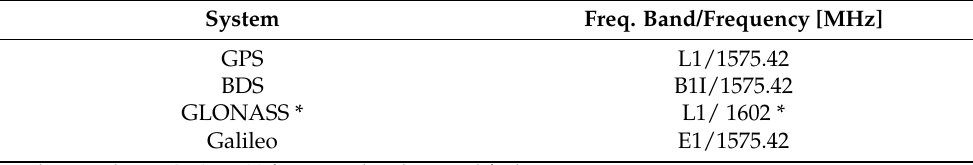
Figure 1. GNSS constellations. Table 2. GNSS Frequency.